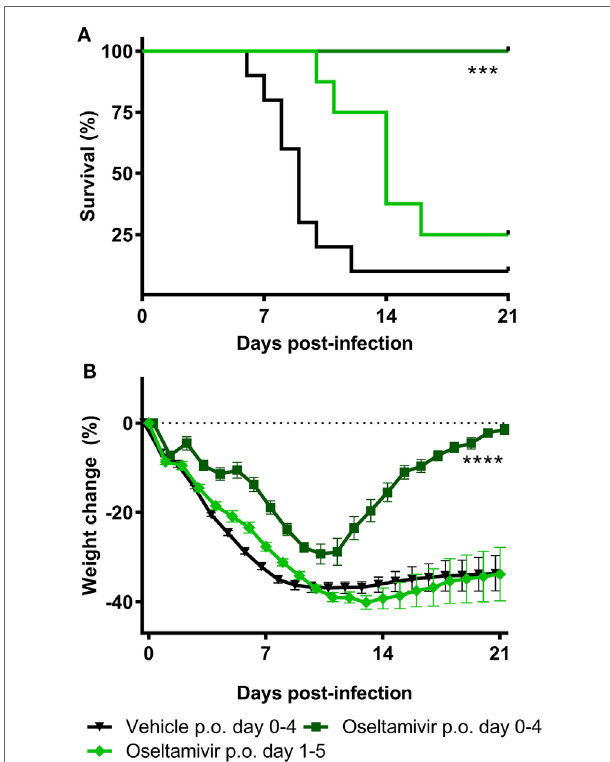
FigUre 2 | Efficacy of oseltamivir in a lethal BALB/c mouse model. Female BALB/c mice were challenged with a dose of 4MLD 50 influenza A/ Anhui/1/2013 (H7N9) on day 0. Mice received 100 mg/kg twice daily p.o. Oseltamivir treatment from days 0–4 or 1–5 ( n = 8 per group) or the vehicle control ( n = 10) from days 0–4. Kaplan–Meyer survival curve (a) and mean body weight change (B) are depicted. Survival proportion in the oseltamivir treated groups was analyzed using a Fisher’s exact two-sided test with Bonferroni correction for multiple comparisons. The effect of oseltamivir treatment on body weight was analyzed by comparing the area under curve of treatment groups with vehicle and was analyzed using a two-way ANOVA with Bonferroni correction. Error bars depict SEM. **** p < 0.001, **** p <